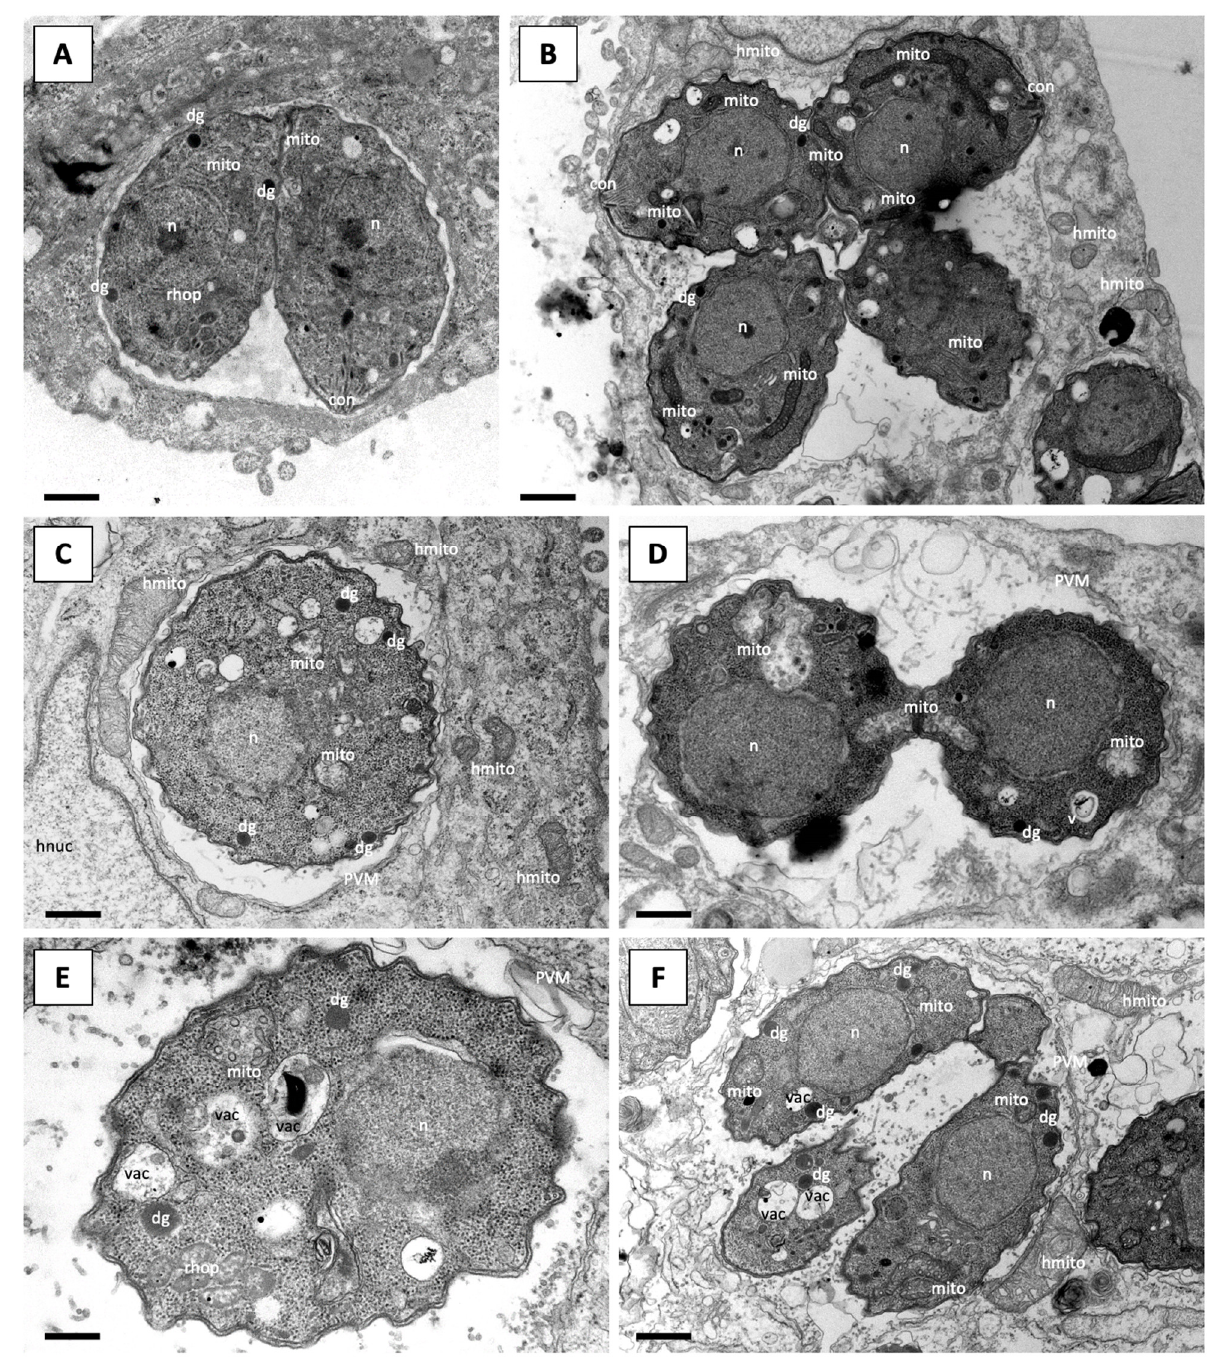
Figure 3. TEM of T. gondii Me49 tachyzoites cultured in vitro in HFF host cells. HFF monolayers were infected with T. gondii tachyzoites and drug treatment was initiated 3 h later. ( A ) and ( B ) show TgMe49 treated with DMSO as control for 6 h and 24 h, respectively. TgMe49 treated with 0.5 µM RMB060 for 6 h are shown in ( C ), 24 h in ( D ), 48 h in ( E ) and 72 h in ( F ). con = conoid; dg = dense granules; mito = mitochondrion; hmito = host cell mitochondrion; n = nucleus; hnuc = host cell nucleus; PVM = parasitophorous vacuole membrane; rhop = rhoptries; vac = cytoplasmic vacuole. Bars in ( A ) = 1 µ m; ( B ) = 1.1 µ m; ( C ) = 0.8 µ m; ( D ) = 0.9 µ m; ( E ) = 0.5 µ m; ( F ) = 1.2 µ